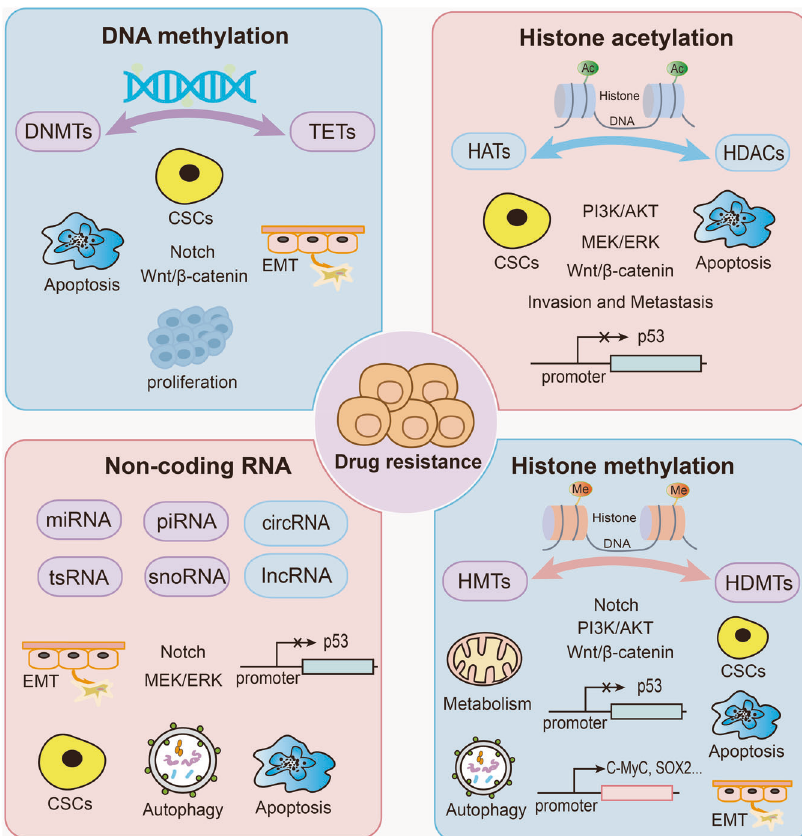
Fig. 3 The roles of different epigenetic modi fi cations in tumor resistance. DNA methylation is co-regulated by DNA methyltransferases and DNA demethylases, mainly in fl uencing apoptosis, stemness, EMT, and cell proliferation through Notch and Wnt/ β -catenin signaling pathways to modulate drug resistance. Non-coding RNAs mainly include four small nucleotides and two large nucleotides, which promote or inhibit tumor resistance. Similarly, histone methylation and acetylation are histone modi fi cations. They keep gene expressions in balance through histone demethylases and methyltransferases, histone acetyltransferases and histone deacetylases, respectively, and function as a double- edged sword in cancer